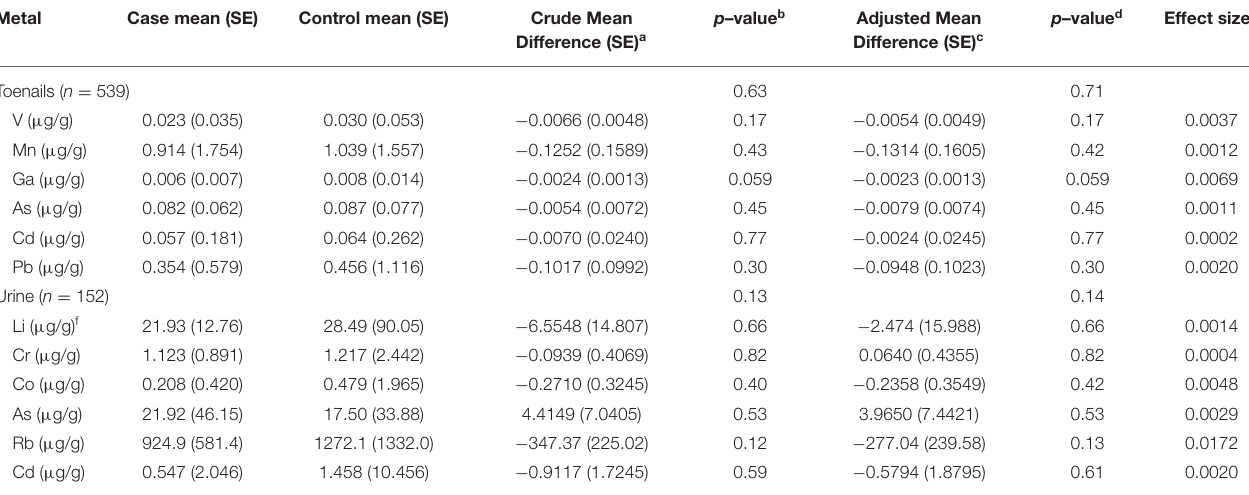
p –value b Adjusted Mean p –value d Effect size e Difference (SE) a Difference (SE) c